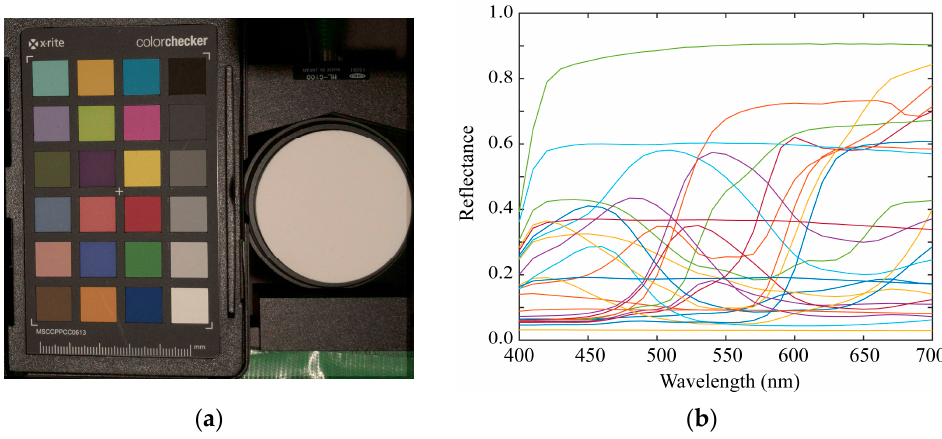
Figure 10. Color checkers used for reflectance estimation validation. ( a ) Imaging targets consisting of 24 color checkers and the white reference standard (Spectralon). ( b ) Spectral reflectances of the 24 color checkers measured by the spectral colorimeter.